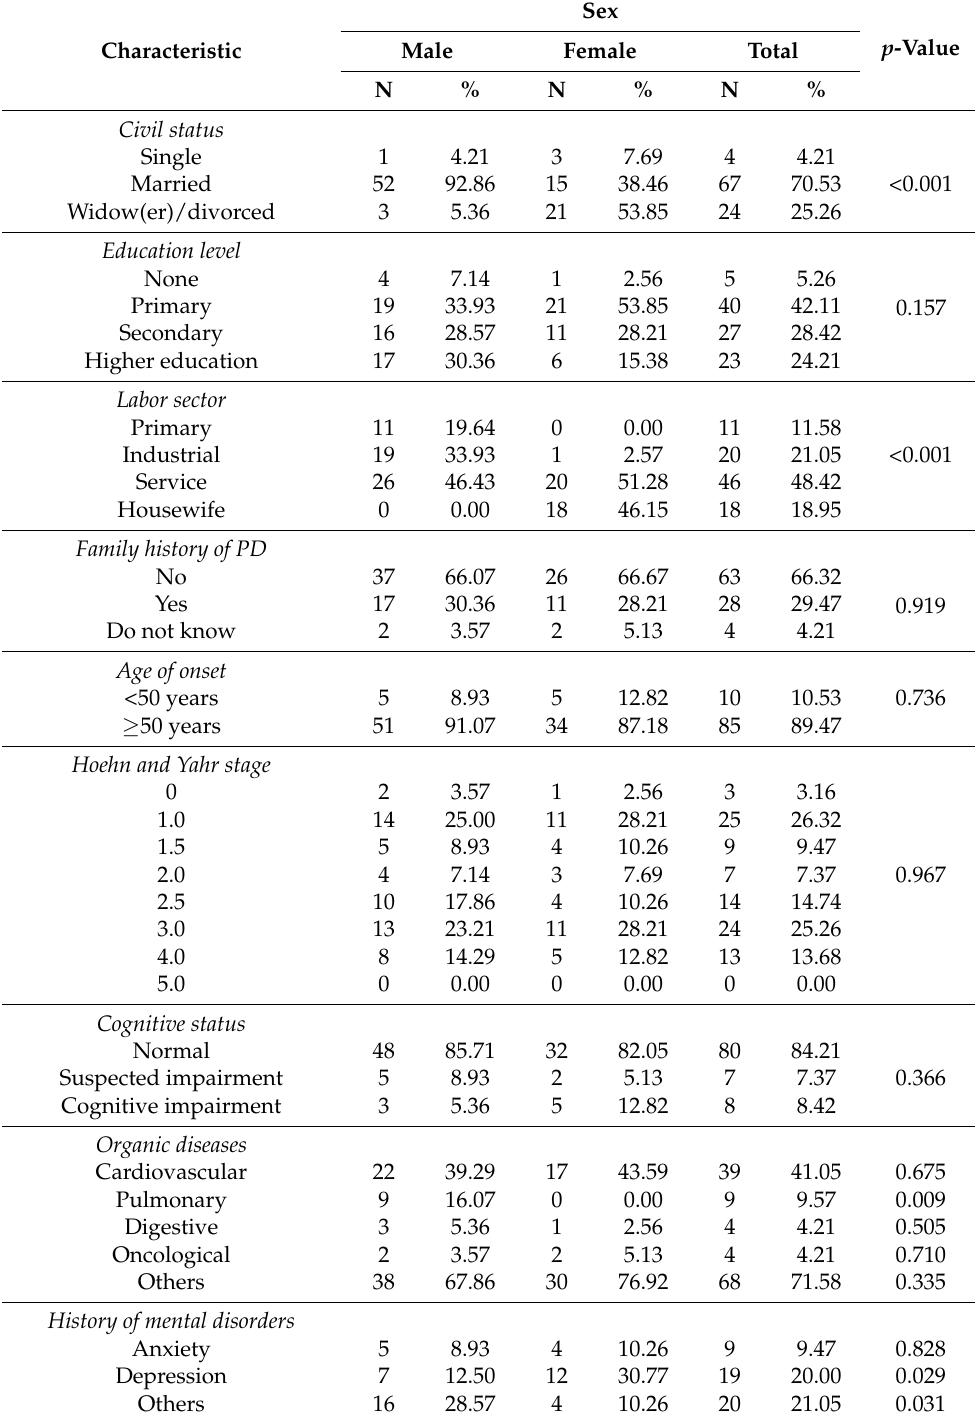
Table 1. Characteristics of the